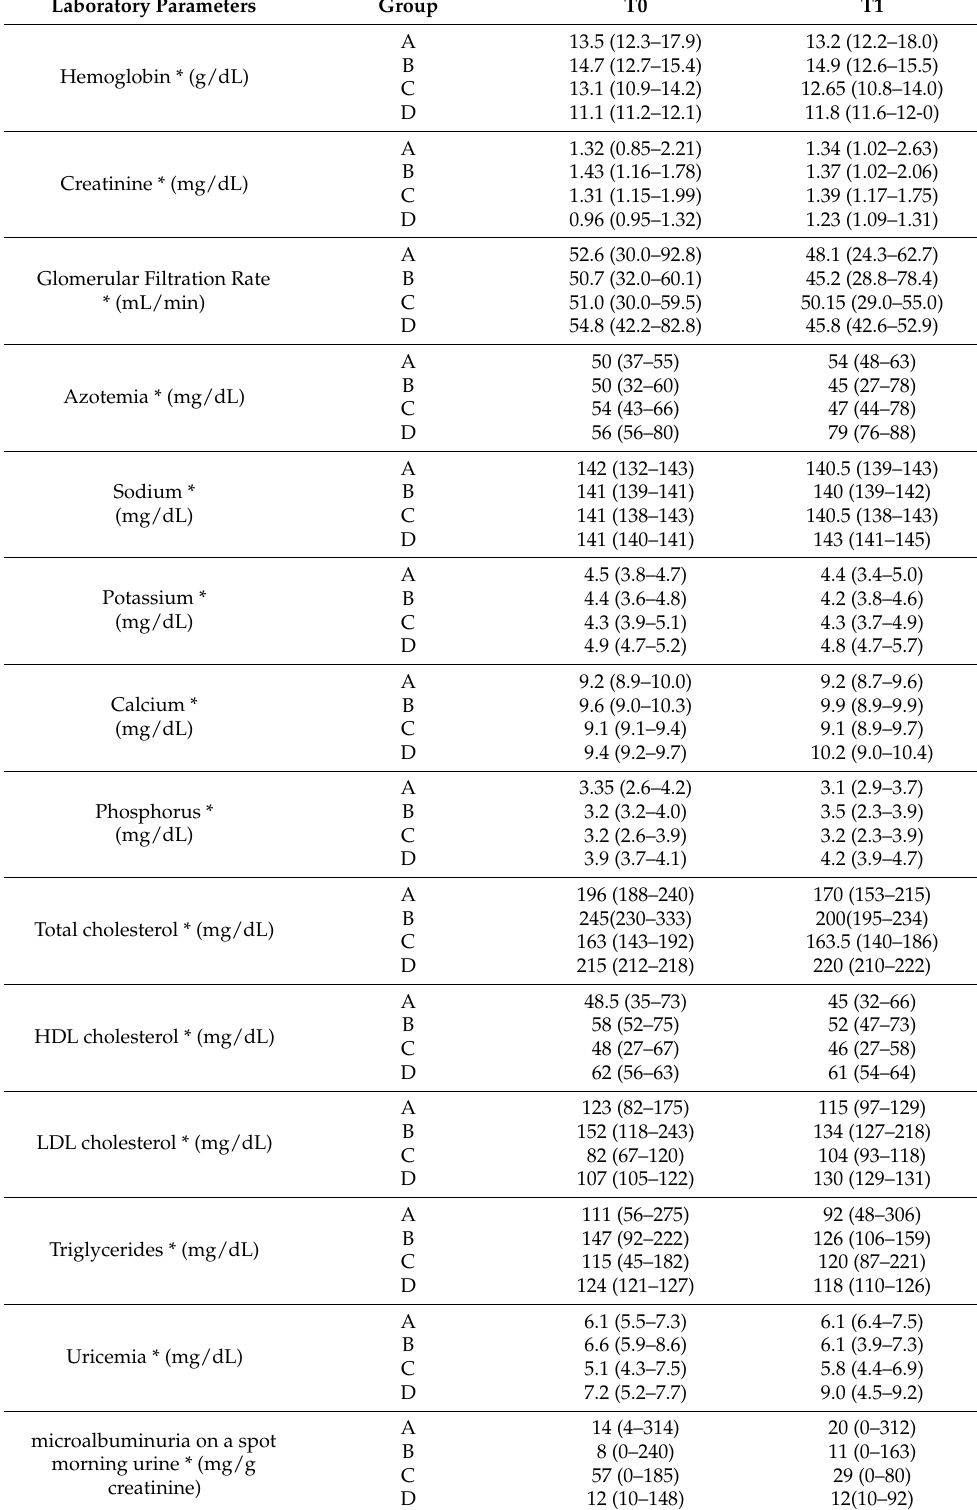
Table 3. Laboratory parameters of the study population divided according to treatment group. * This parameter is represented as median (minimum-maximum). Abbreviations: HDL cholesterol, high-density lipoprotein cholesterol; LDL cholesterol, low-density lipoprotein